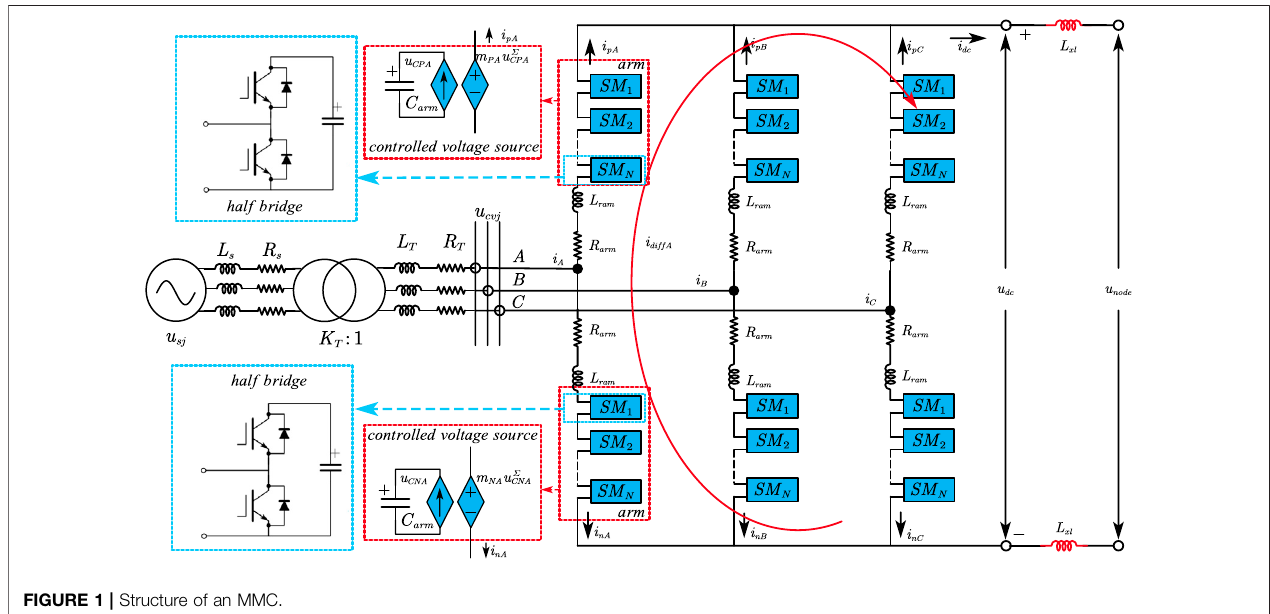
FIGURE 1 | Structure of an MMC.